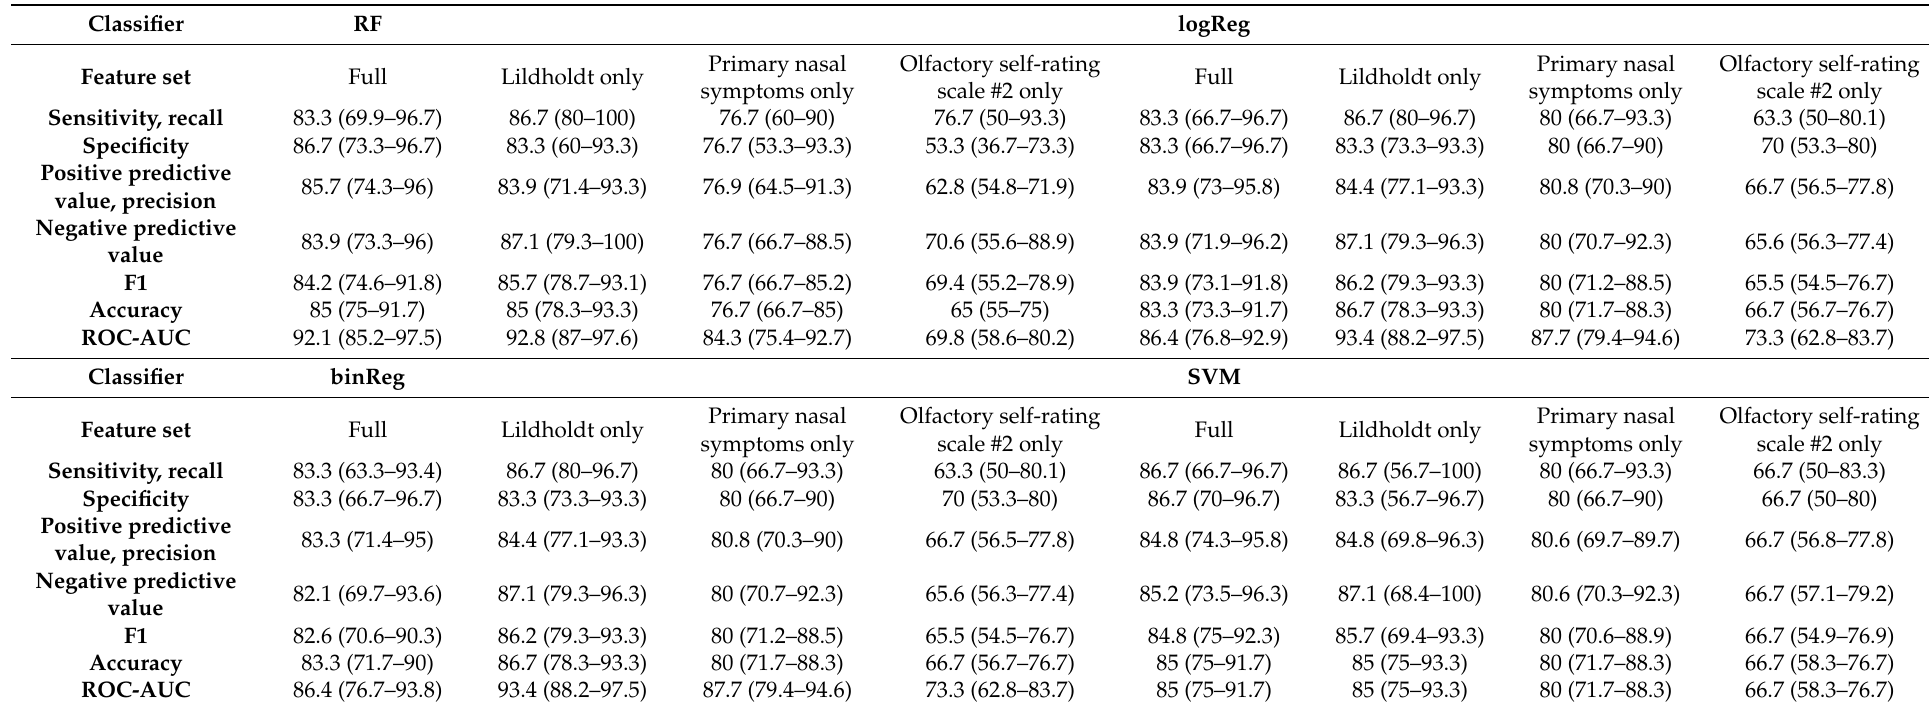
Table 2. Classification performance measures for correctly identifying whether a record was acquired before or after endoscopic sinus surgery are obtained when training different classifiers, i.e., random forests (RF), logistic regression in two implementations (logReg, binReg), support vector machines (SVM), k-nearest neighbors (kNN), naïve Bayes, classifi- cation and regression trees (CART), and a hierarchical rule based C5.0 classifier with the information from d = 37 variables used in Table 1. The results represent the medians and 95% confidence intervals of the performance measures obtained during 1000 runs using a class-proportional random sampling of the data set into disjoint training (2/3 of the data set) and test data subsets (1/3). The classifiers were trained with the full information in d = 37 variables and with the features identified as informative for the task to identify whether a data set instance had been acquired before or after the surgery (Lildholdt score only, primary nasal symptoms only, or olfactory self-rating scale #2 values only; see Figure 4). Note that class sizes were equal; therefore, accuracy and not balanced accuracy is